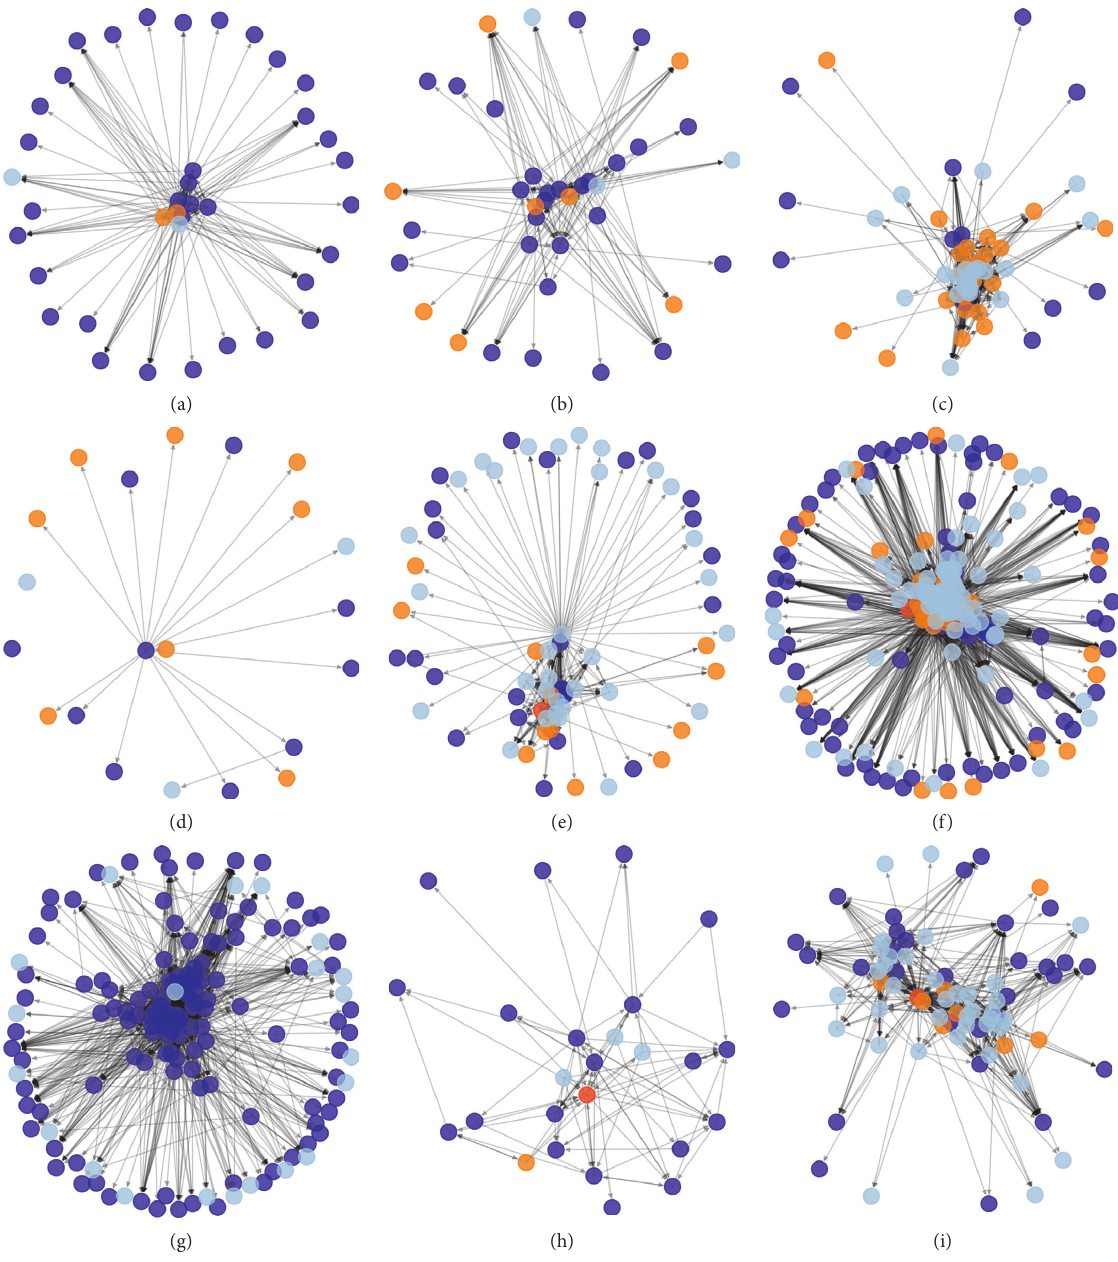
Figure 2: Visualization of functional communication networks from select enterprises. Distinct networks represent different enterprises. Nodes are user colored by their role (red is for an executive, dark blue is for a manager, orange is for a supervisor, and light blue is for an operator). Directed edges are work orders. Networks have a hub-spoke shape, consisting of a middle core and a radial periphery. Nodes were positioned using the Fruchterman–Reingold force-directed algorithm [40]. Other enterprises are shown in Section